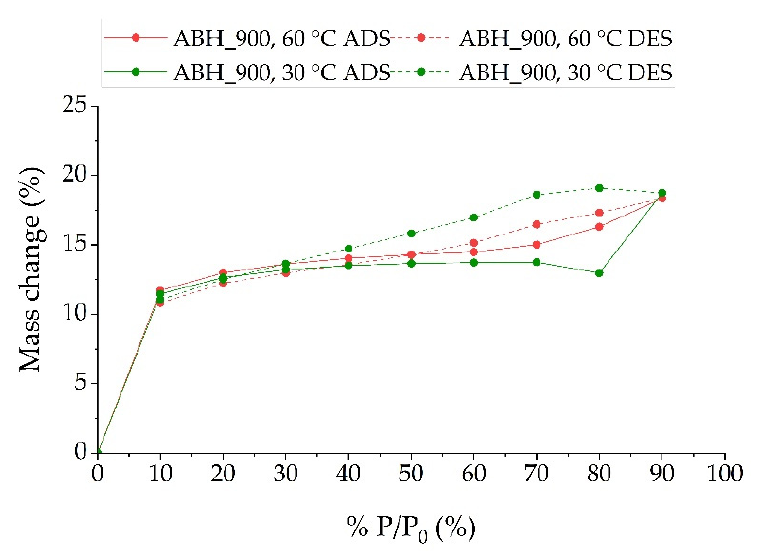
Figure 8. Adsorption and desorption isotherms for the sample ABH_900 at 30 and 60 °C.